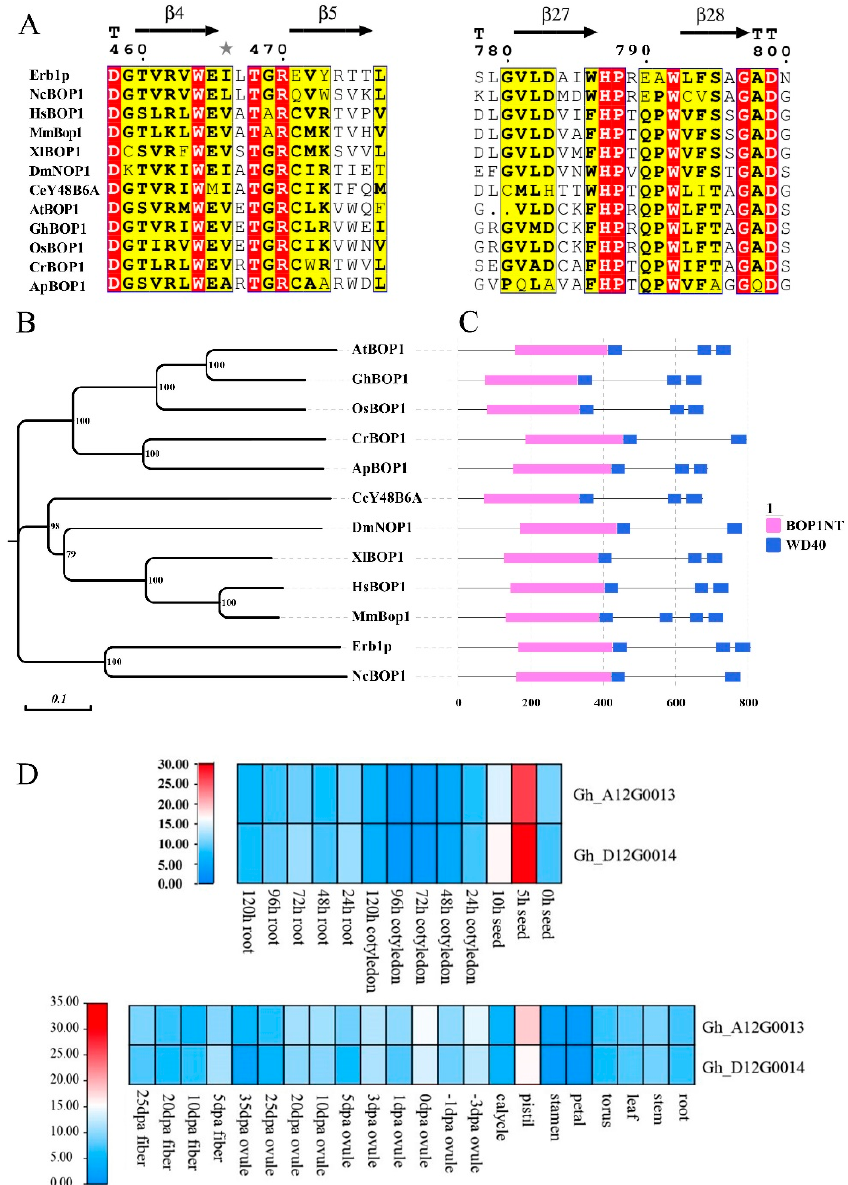
Figure 1. Characterization of Block of Proliferation 1 (BOP1) in different species and expression of GhBOP1 in cotton at different periods. ( A ) The highly conserved amino acid residues of BOP1 in different species are highlighted (red box). ( B ) Adjacency tree of BOP1 between different species, based on 1000 repeated lead values displayed next to branch points. ( C ) Domain structure composition of BOP1 proteins in different species: the two conserved motifs in BOP1 protein are represented by pink (BOP1NT) and blue (WD40 repeat) boxes, respectively. ( D ) Expression of GhBOP1 in different time periods and tissues. Gh_A12G0013 is the GhBOP1 gene number on chromosome A12, and Gh_D12G0014 is the GhBOP1 gene number on chromosome